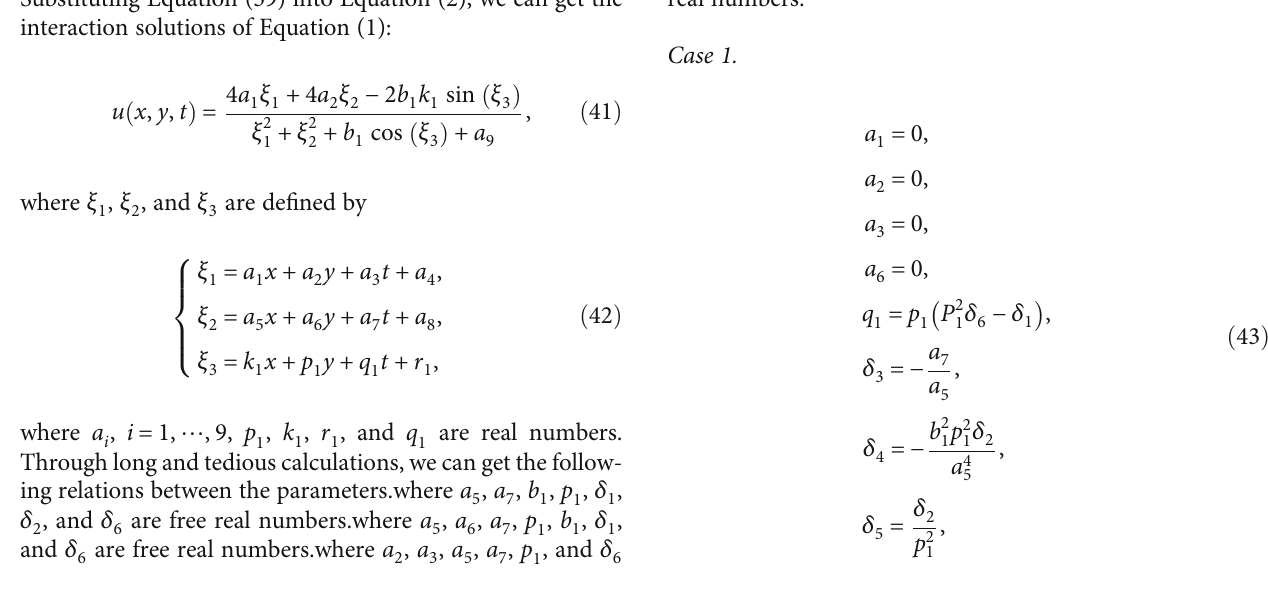
Figure 9: Spatiotemporal structure of solution (37) with the parameter selections: (a) t = − 10 , a (b) t = 0 , a 2 = 1 , p 1 = 1 , a 3 = 1 , a 7 = 1 , a 5 = 1 , and δ 6 = 1 ; (c) t = − 10 , a 2 = 1 , p 1 = 1 , a 3 = 1 , a 7 = 1 , a 5 = 1 , and δ 6 = 1